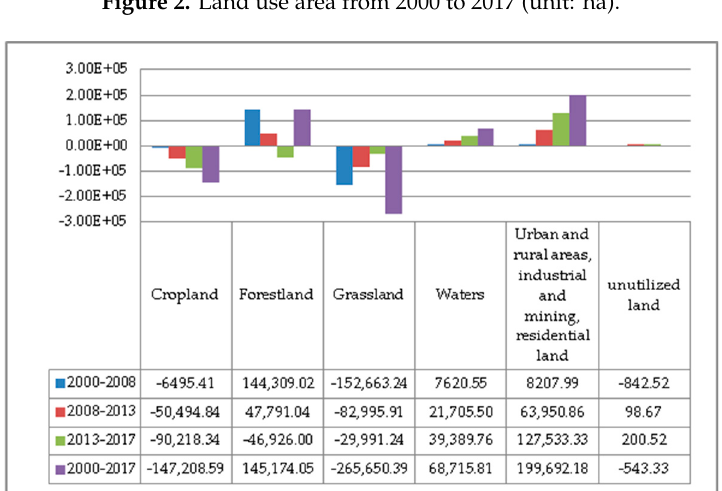
Figure 2. Land use area from 2000 to 2017 (unit: ha).